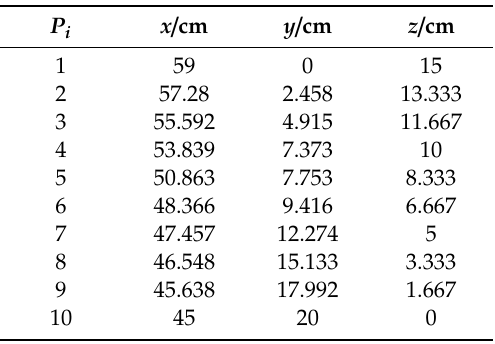
Table 4. Path points of the end-e ff ector.